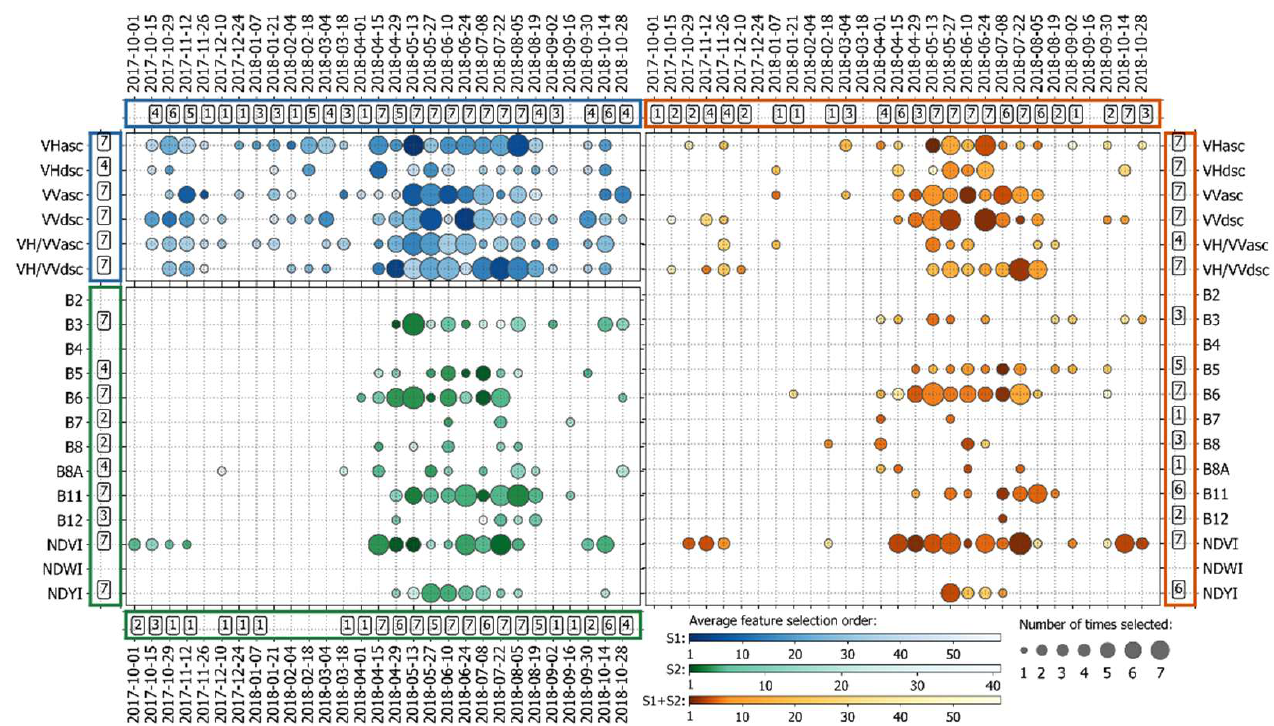
Figure 11. Analysis of feature selection results with spatial feature selection. The abbreviation keys are provided in Table 2. Outer boxes: The number of times a variable group ( y -axis) or a time group ( x -axis) was selected by spatial gFFS on runs with only SAR (blue borders), only optical (green border), and optical-SAR feature combinations (orange borders). Inner boxes: The single features, selected in the last step of spatial gFFS. The circle sizes represent the number of times a feature was selected, and the colour intensity represents the median order (sequence) at which it was selected.